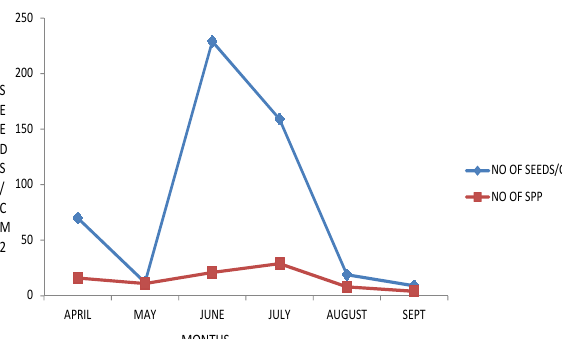
Fig. 3. Monthly emergence of seedlings and species at both depths Fig. 4. Monthly emergence of seedlings and species at both